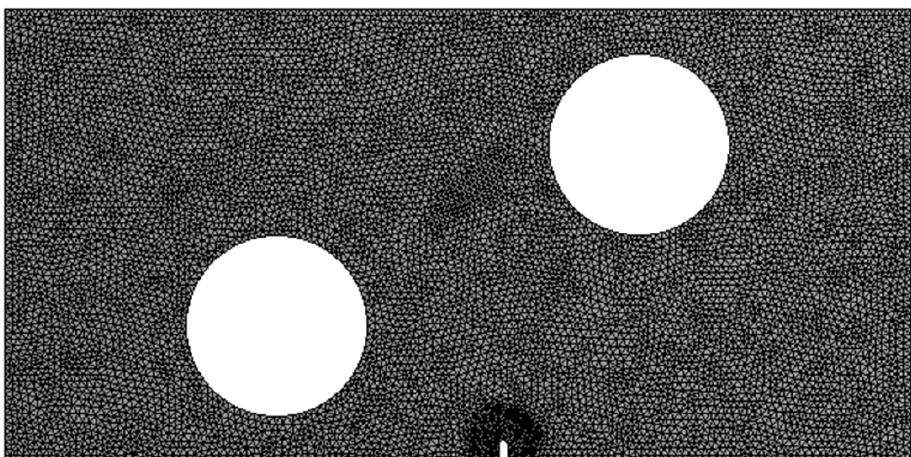
Figure 5. Geometrical representation of the rectangular structure with two holes and one central crack.